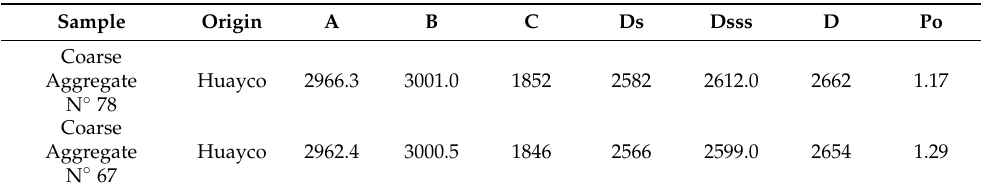
Table 4. Coarse aggregate Absorption from San Eduardo Plant.